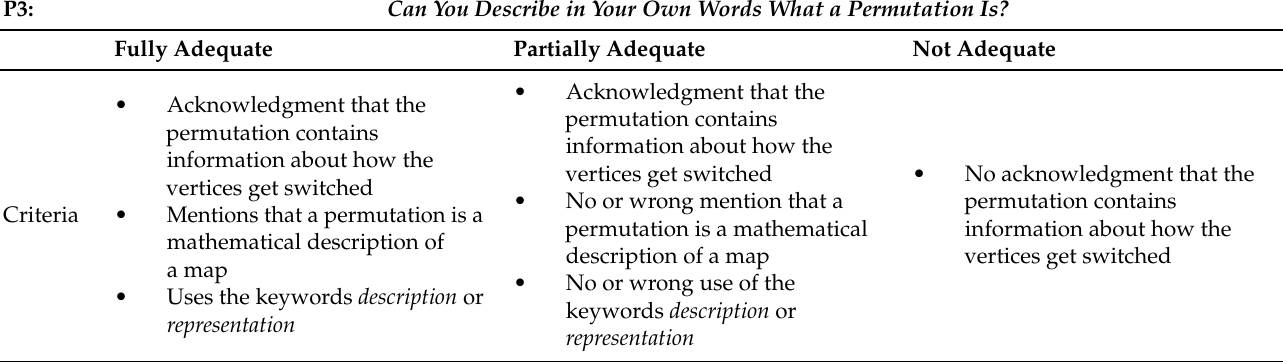
Table A11. Coding manual for the paraphrasing of key idea